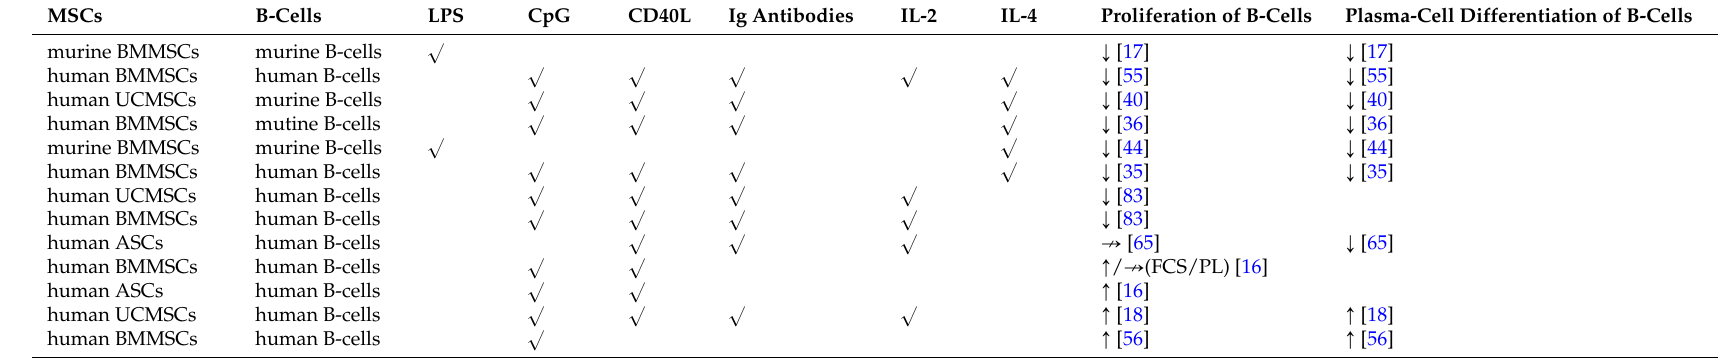
Table 2. Correlation between stimulators in culture media (LPS, CpG, CD40L, and Ig antibodies IL-2 and IL-4) and the immunoregulation of B-cells by MSCs.